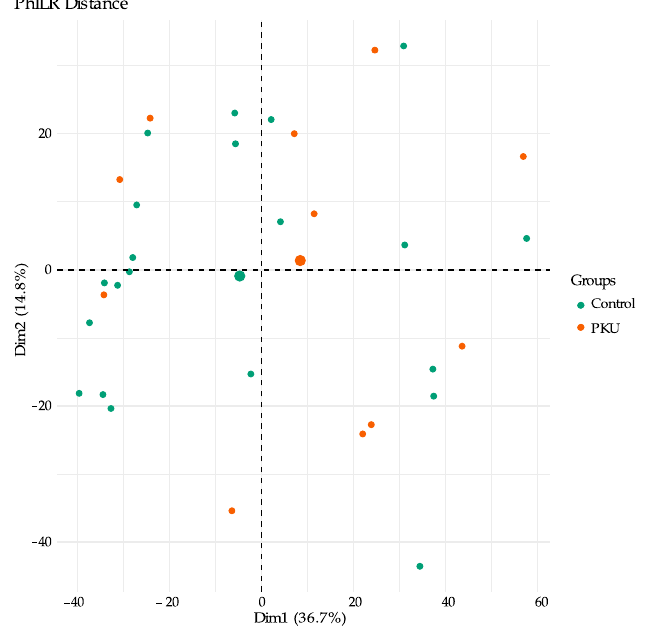
Figure 4. Alpha diversity for PKU and control samples. Statistical significance of the ( A ) number 214 of observed ASVs and ( B ) Shannon diversity index from PKU and control samples were calculated 215 and compared with the Wilcoxon rank-sum test. Median scores are represented with a horizontal 216 line, the box outer limits represent the first to third quartiles, the whiskers indicate the range of 217 measurements for each group, and each point denotes a sample. Observed ASVs (Wilcoxon: W = 218 143, p = 0.28) and Shannon index (Wilcoxon: W = 139, p = 0.37). 219